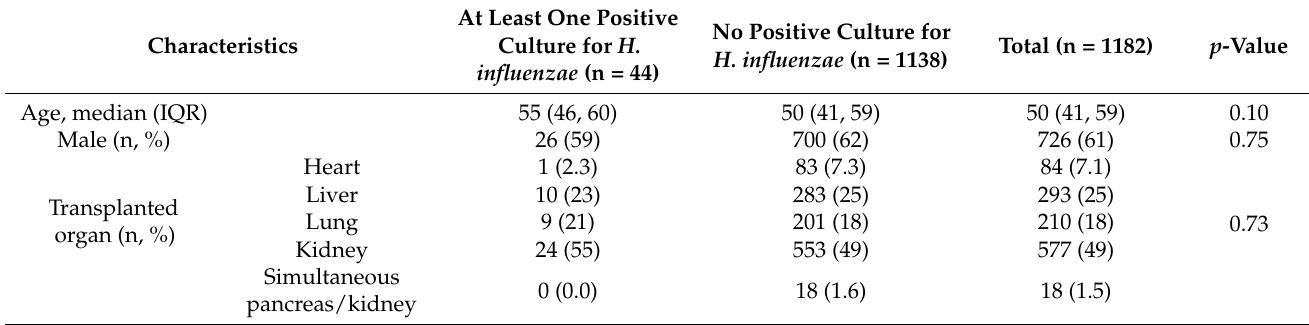
Table 3. Characteristics of solid organ transplant recipients who had and did not have at least one episode of H. influenzae